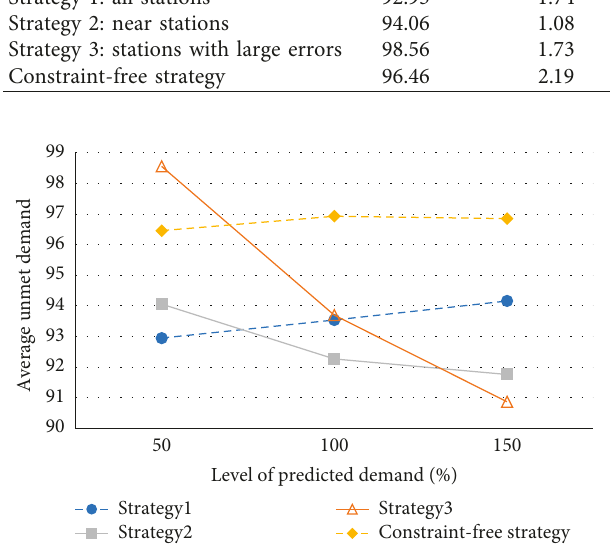
Figure 8: Average unmet demand by